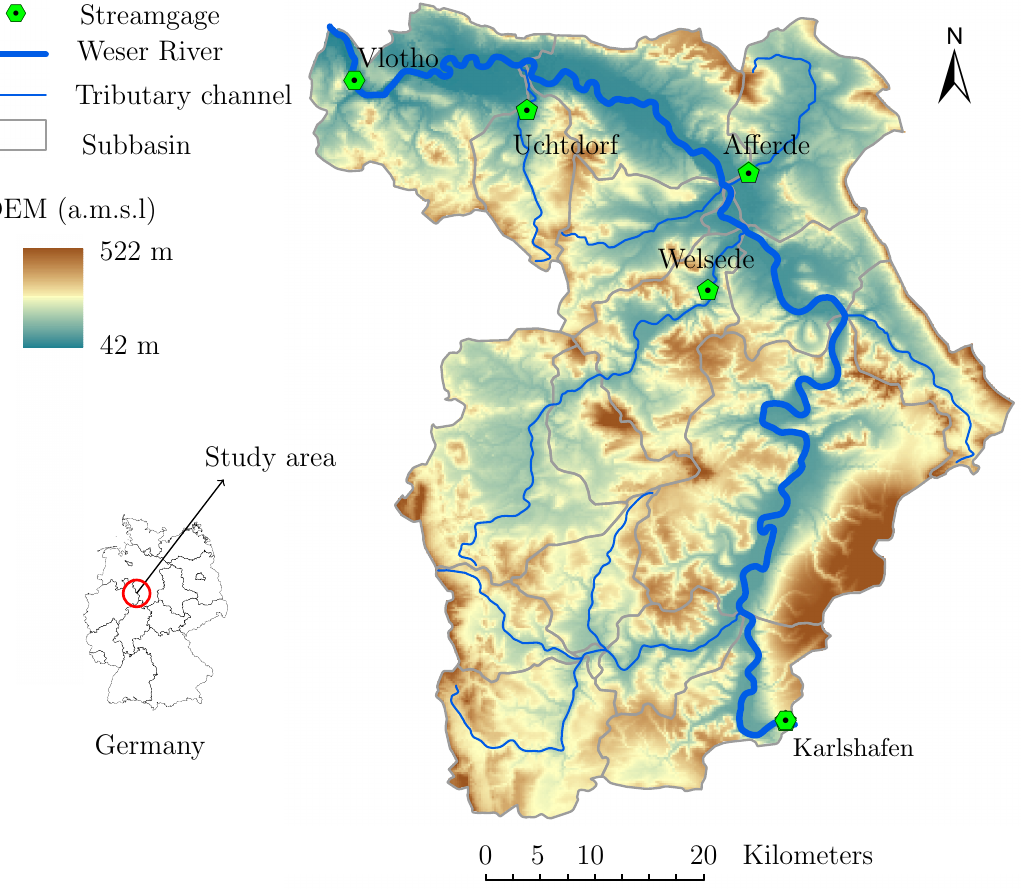
Figure 1. Location of the Weser River segment and its tributary